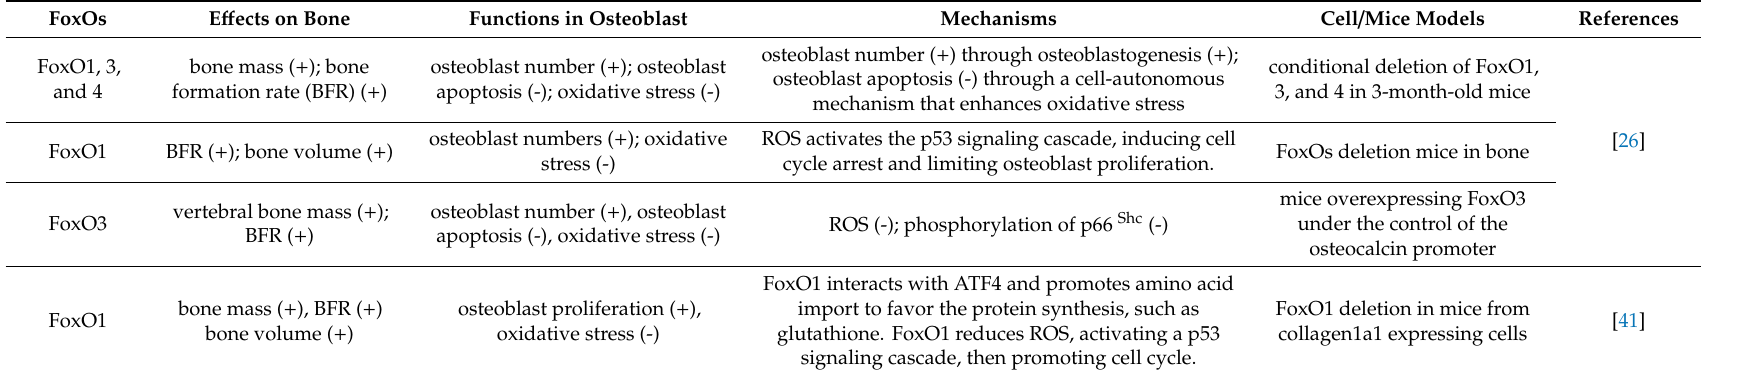
Table 2. Bone metabolism regulatory functions of FoxO transcription factors in